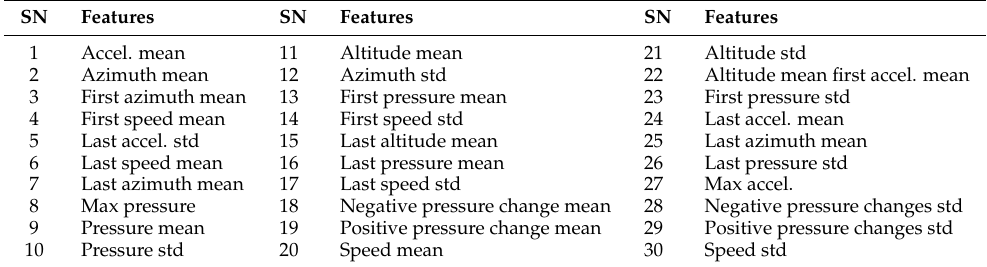
Table 3. List of selected features using SFFS.